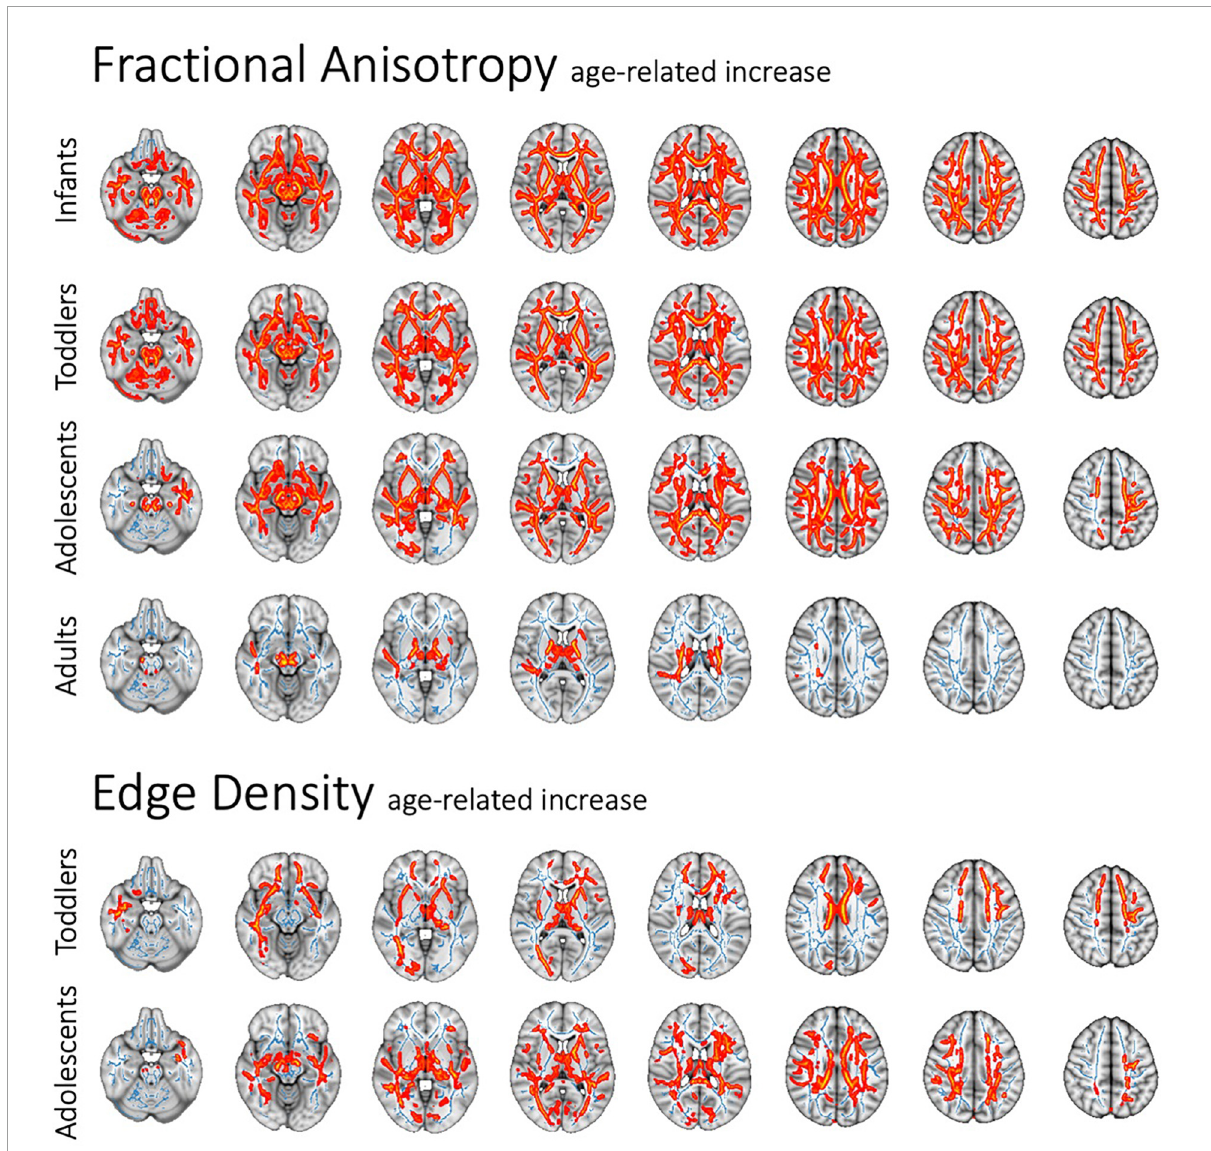
FIGURE2 Age-related pervasive decrease in FA and (to lesser degree) ED throughout WM tracts in voxel-wise analysis, independent of ASD diagnosis or sex. Figure shows the standard MNI152 brain template overlaid with the mean FA skeleton resulting from TBSS (blue), as well as all significant changes ( p < 0.05)